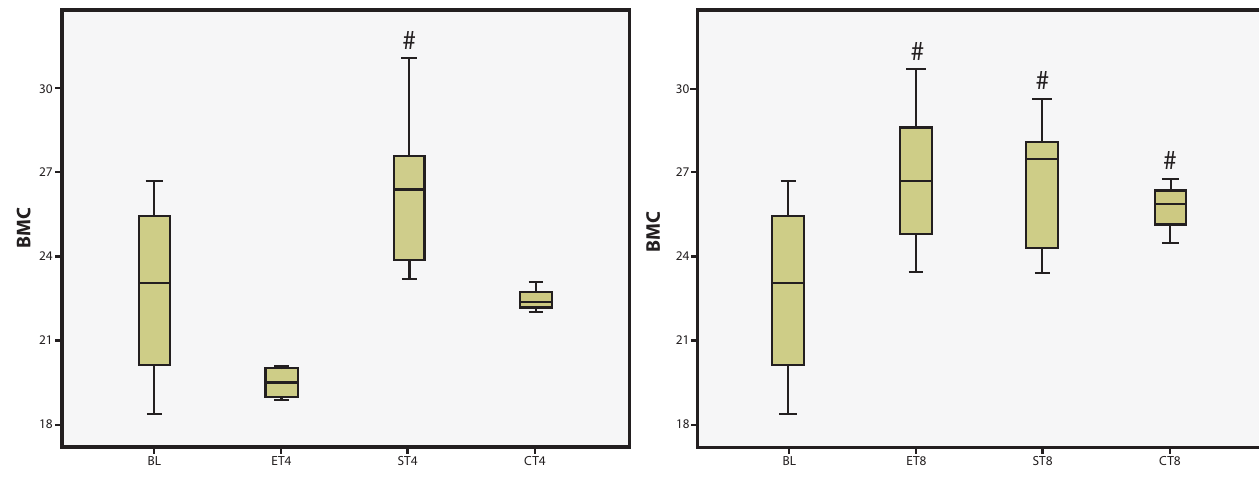
Figure 3: Box-plot with the values of BMC (g). # Significant difference in relation to the ET4